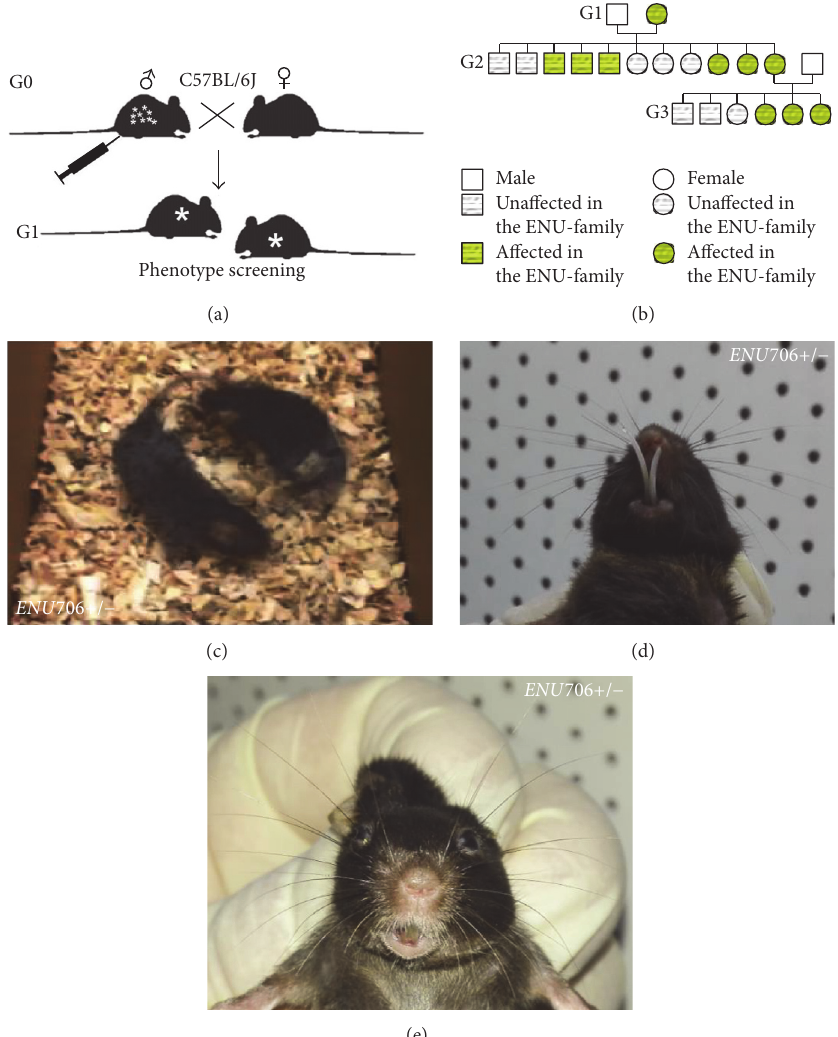
Figure 1: Identification of a mutant line ENU706 by ENU-mutagenesis screening. (a) The strategy for our ENU screen on C57BL/6J mice. The male founder mouse was injected with mutagen and cross with female mice. The G1 mice were sent for phenotype screening for dominant phenotypes. (b) The family pedigree for the ENU706 line. (c) Representative image of circling behavior in a heterozygous ENU706 mouse. The syndromic traits were inherited in a dominant manner. Some of the heterozygous mutant mice showed abnormal craniofacial development including (d) elongated teeth and (e) asymmetrical